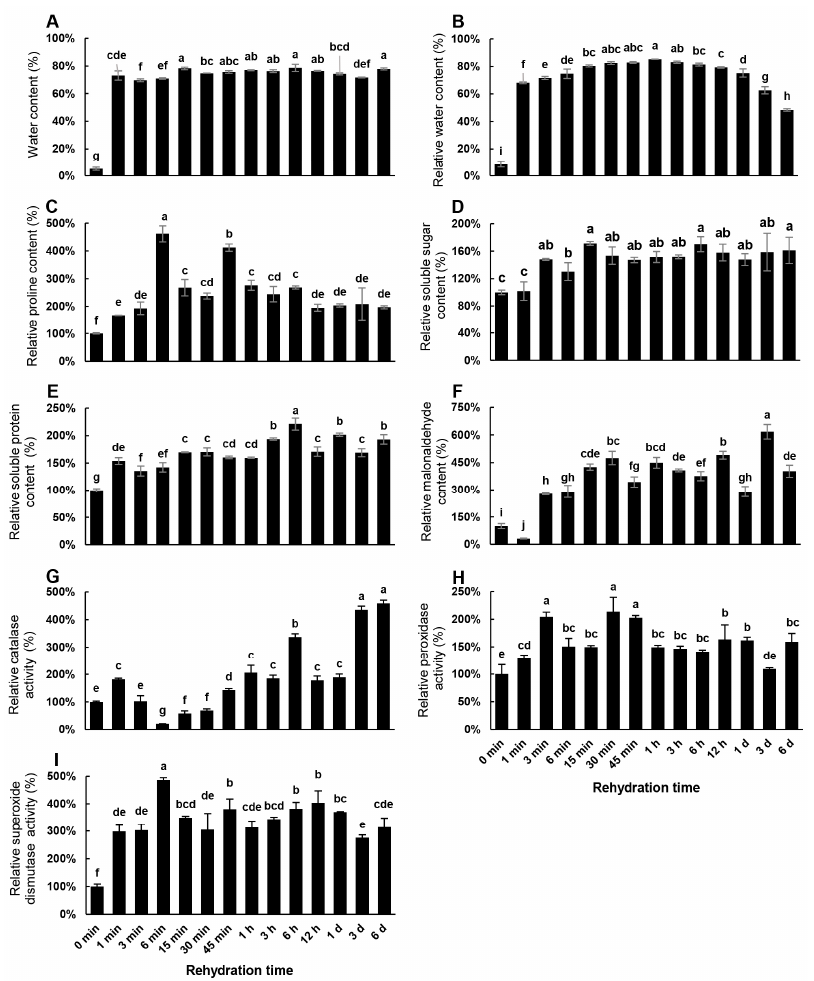
Figure 2. Physiological and biochemical changes of desiccated R. canescens in response to rehydration: ( A ) water content; ( B ) relative water content; ( C ) proline content; ( D ) soluble sugar contents; ( E ) soluble protein contents; ( F ) malonaldehyde content; ( G ) catalase activity; ( H ) peroxidase activity; ( I ) superoxide dismutase activity. Data are mean ± standard deviation (SD) of three replicates, letters above error bars indicate significance determined by one-way ANOVA using Duncan method by IBM SPSS 20.0 software (IBM, NY, USA), P < 0.05.